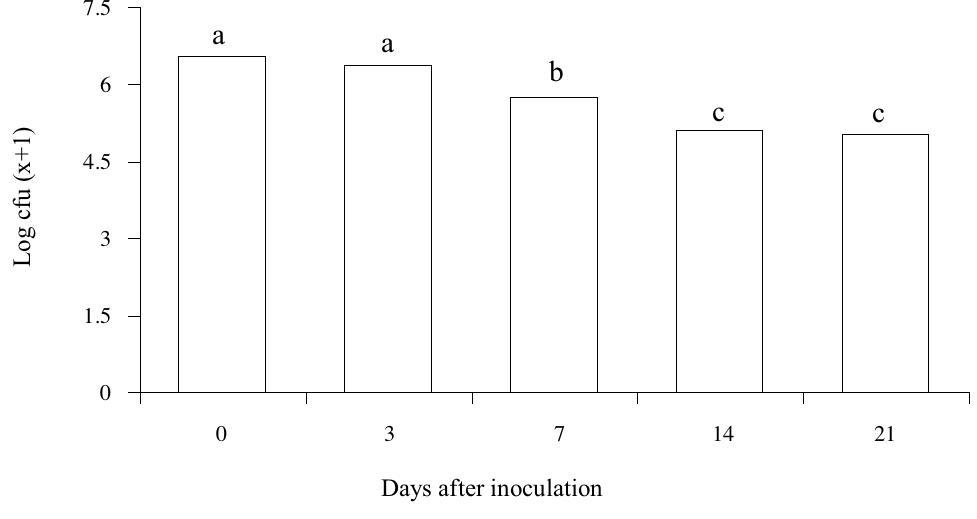
Fig. 2. Cfu of Pseudomonas aeruginosa strain IE-6S + isolated from the rhizosphere of the strain-treated half of the split root system. The bacterium was not isolated from the unbacterized half. Bars with the same letter are not significantly different at P <0.05 according to Duncan’s multiple range